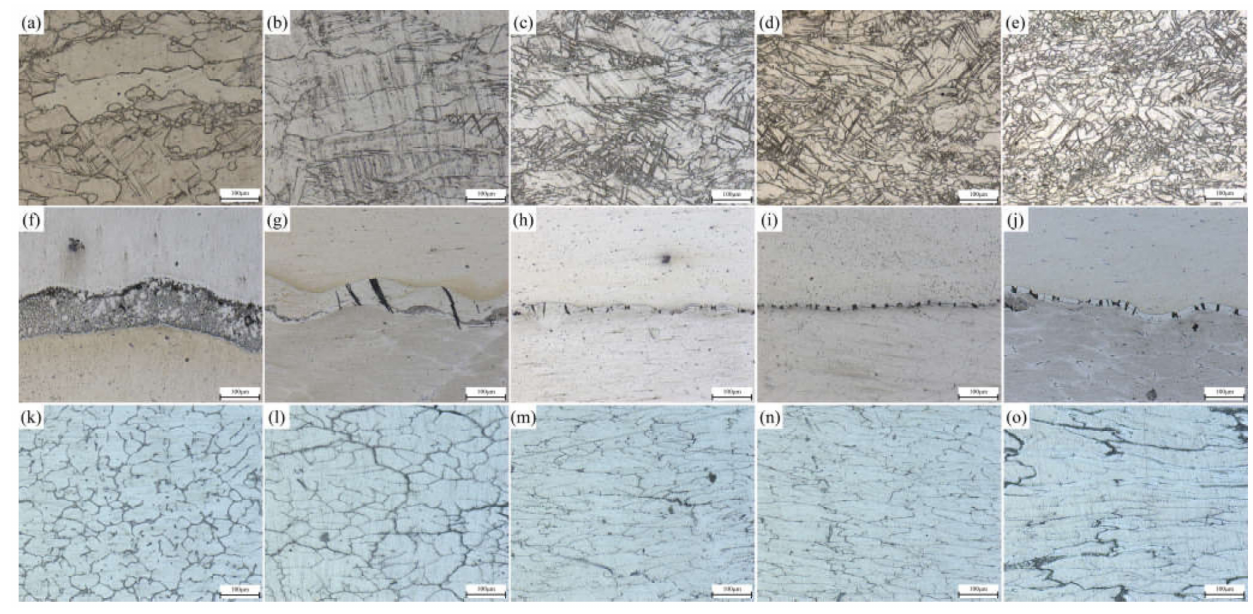
Figure 3. Interface of Al/Mg composite plate under different rolling passes: Mg side: ( a ) not rolled, ( b ) first pass, ( c ) second pass, ( d ) third pass, ( e ) fourth pass; Intermediate bonding layer: ( f ) not rolled, ( g ) first pass, ( h ) second pass, ( i ) third pass, ( j ) fourth pass; Al side: ( k ) not rolled, ( l ) first pass, ( m ) second pass, ( n ) third pass, ( o ) fourth pass.